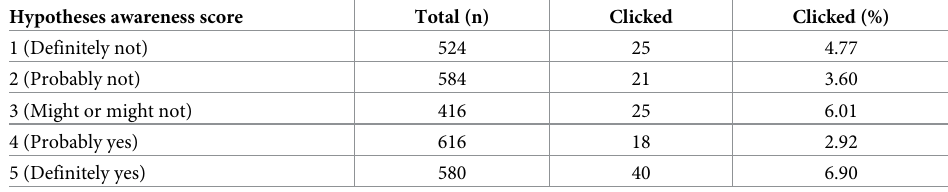
Table 4. The number (n) and percentage (%) of link clicking responses on pet profiles by study hypotheses aware- ness scores (1–5).